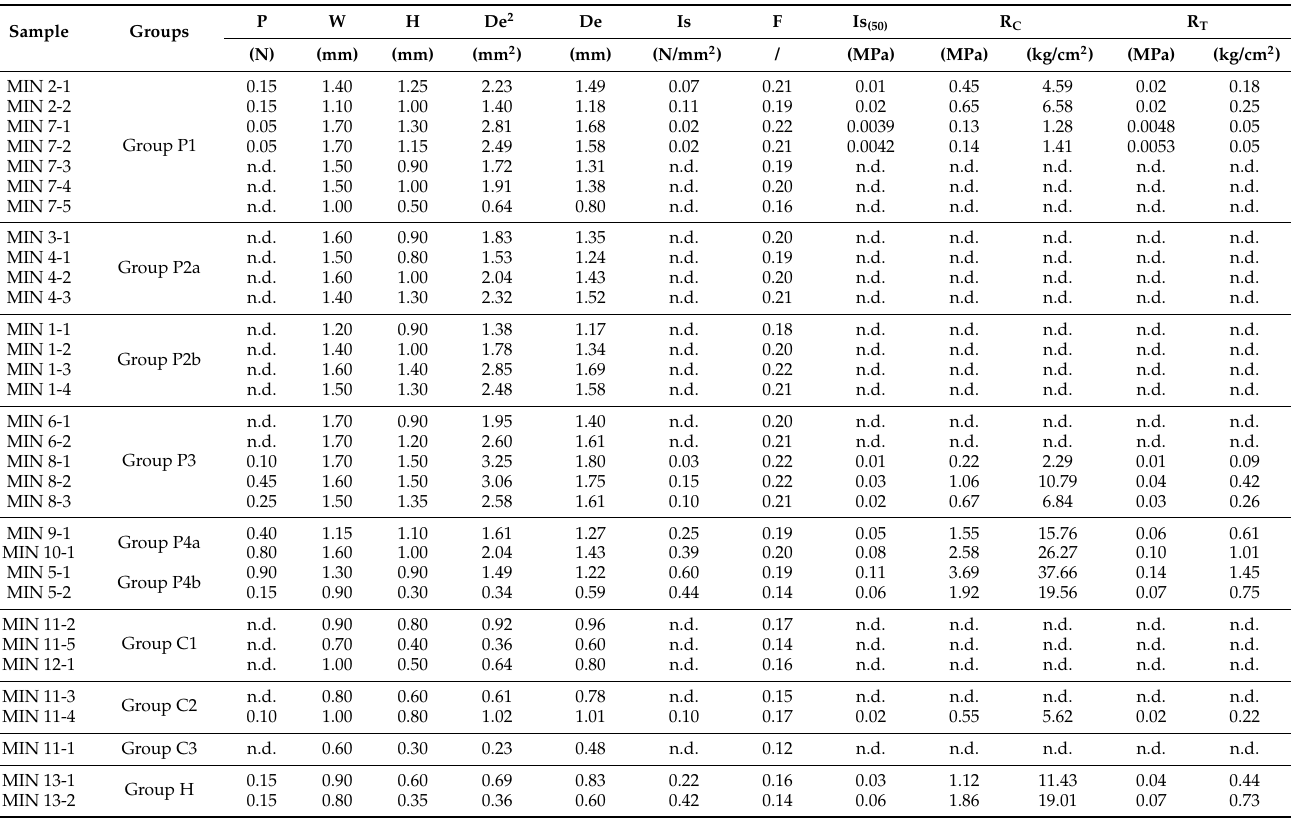
Table 4. Data of mechanical Point Load Test of samples belonging to Area B and house-fort from Cap de Forma archaeological